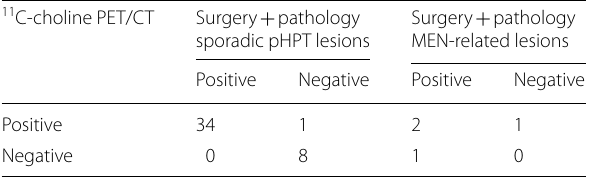
Table 3 Final 11 C-choline PET/CT lesion-based outcome for the on 11 C-choline PET/CT. The other false positive lesion 37 resected adenomas includes the aforementioned patient with adenomas on both sides of the neck. In retrospect, the false positive 11 C-choline PET/CT Surgery pathology Surgery pathology + + sporadic pHPT lesions MEN-related lesions may have been due to reactive lymph nodes and thyroiditis, as was found in the pathological examination (Table 4). Overall, per-lesion sensitivity of 11 C-choline PET/CT for all parathyroid lesions was 97% (100% for sporadic lesions and 67% for MEN related lesions, respectively), pHPT primary hyperparathyroidism; MEN multiple endocrine neoplasia = = the PPV 95% (97% sporadic and 67% MEN) and the accu- racy 94% (98% sporadic and 50% MEN). There was one patient with MEN-IIA syndrome where the 11 C-choline PET/CT showed a lesion in the right Follow‑up lower quadrant, but the adenoma was localized elsewhere Median albumin-corrected calcium and PTH level on during surgery (right upper). Hence, a false positive and false negative localization was registered (Table 4). This false negative lesion could in retrospect be identified